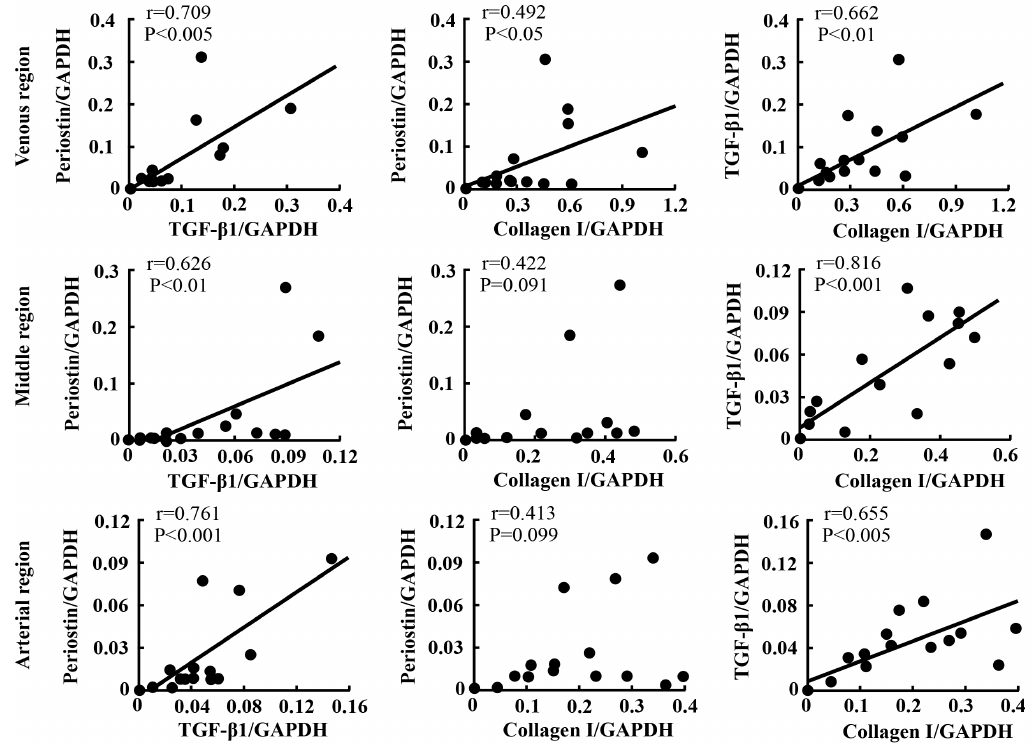
Figure 7. Linear regression analyses of the correlations among the expression levels of periostin, TGF-β1, and collagen I at arterial, middle, and venous regions after PTFE graft implantation, independent of time point.